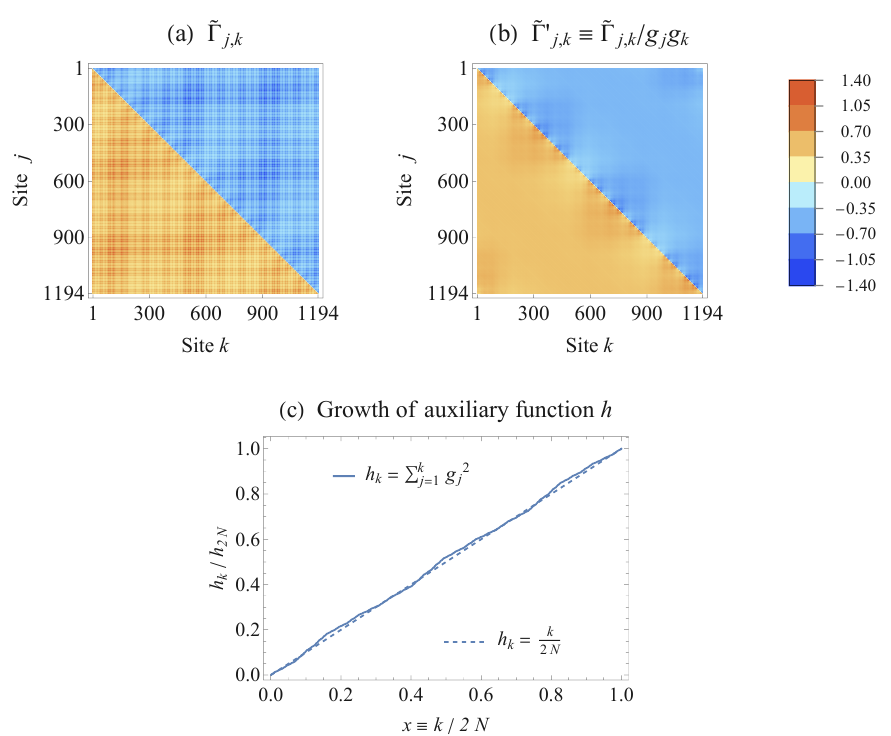
Figure 3 . (a) Decay-adjusted covariance matrix ˜Γ (as defined in eq. (3.1)) for the boundary state of a { 3 , 7 } matchgate tensor network (MTN) of N = 597 sites ( n = 5 inflation steps) at the critical Ising point. (b) Nearly translation-invariant matrix ˜Γ 0 computed by applying a site-dependent disorder vector, computed via eq. (3.4), on ˜Γ . (c) The integrated squared disorder vector grows close to linearly on large scales and thus fulfills the condition (A.14) for the validity of the mode- disordered Ising (MDI) parent Hamiltonian